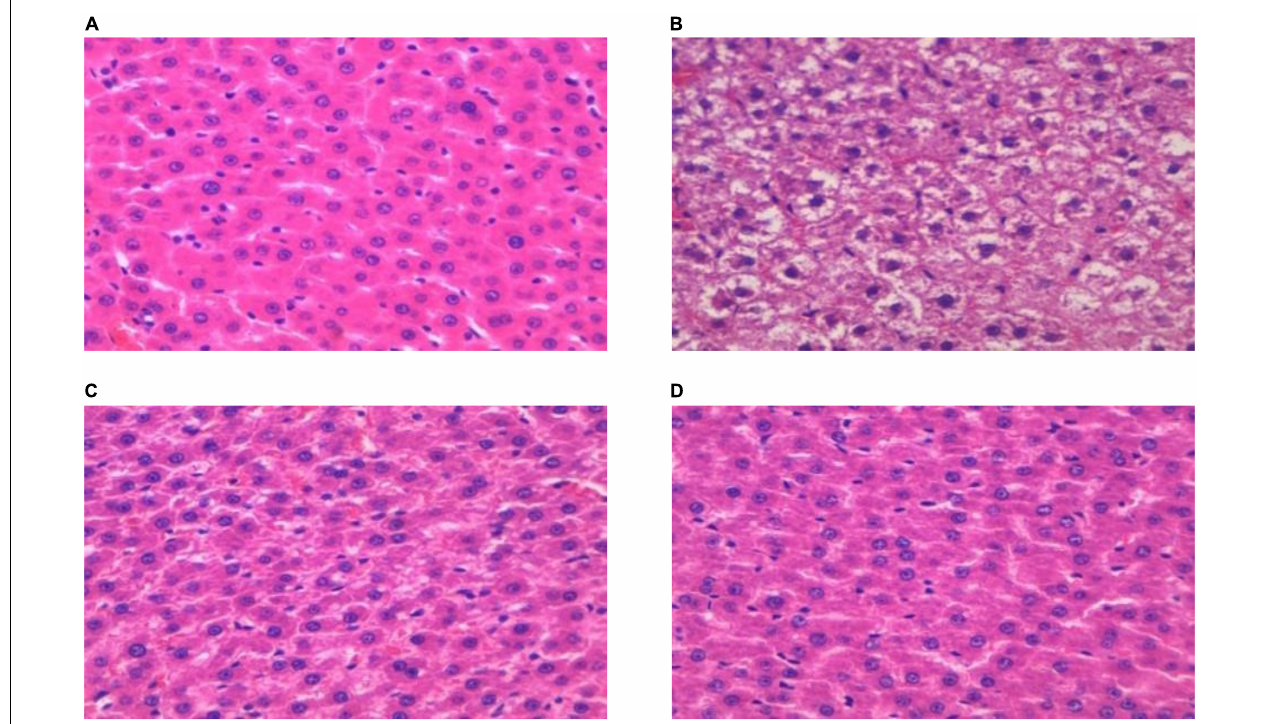
FIGURE 4 | H&E staining of the hepatic (400 × ). (A) CON; (B) DM; (C) MET; and (D)